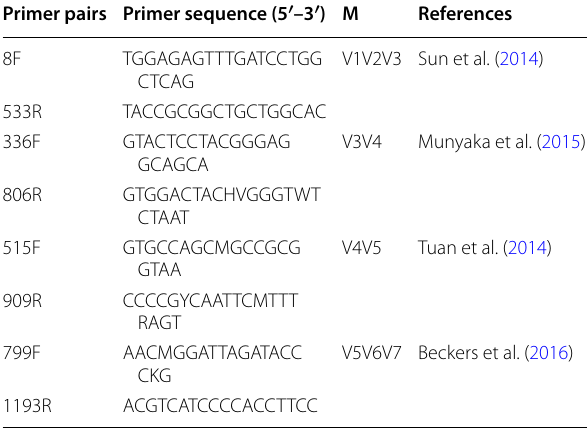
Primers are indicated as forward (F) or reverse (R) M, Hypervariable region of the 16S rRNA operon targeted by primer pairs